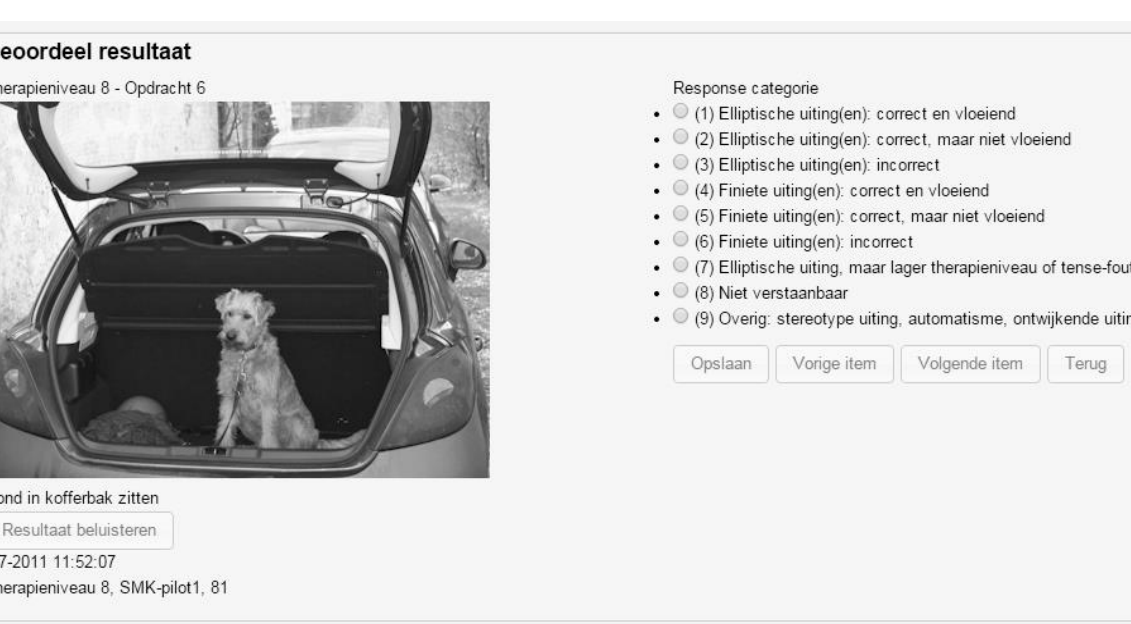
Figure 2. Therapist interface of the sixth item (target utterance: Hond in kofferbak zitten , ‘Dog sitting in trunk of the car’) when enrolled in the second cycle of the eight therapy level (for an explanation see